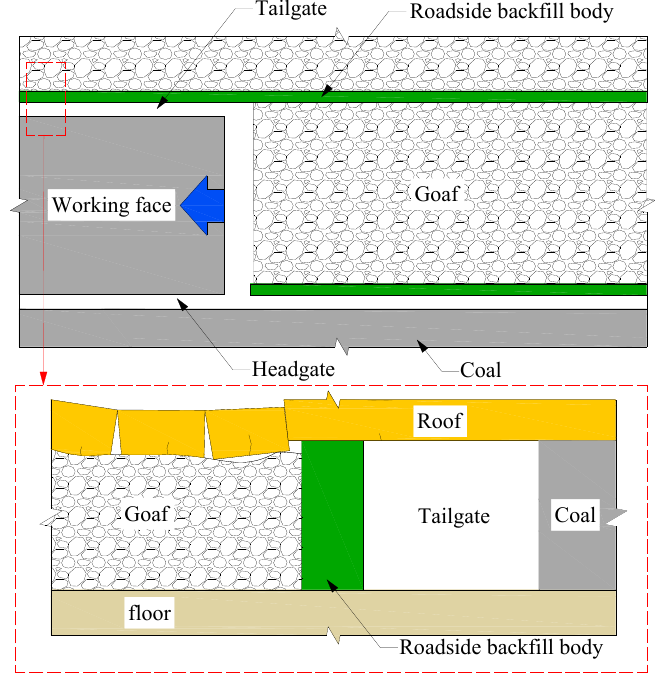
Figure 1. Technical diagram of roadside backfill body.